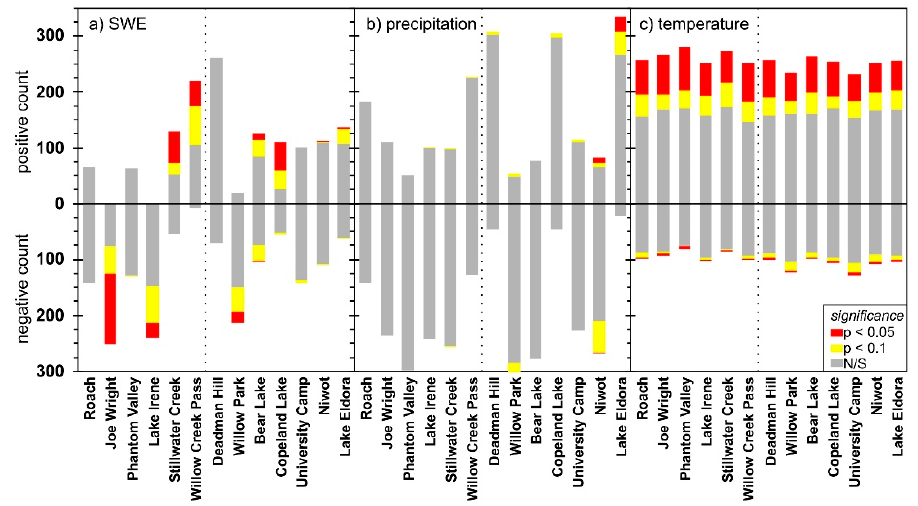
Figure 5. Significance of the daily trends for ( a ) SWE, ( b ) cumulative precipitation, and ( c ) temperature, differentiated by positive and negative trends illustrating the confidence levels of p < 0.05, p < 0.10, and not significant (N/S).